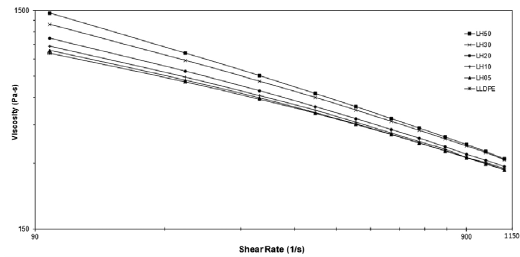
Figure 4. Variation of apparent viscosity with shear rate for the samples.